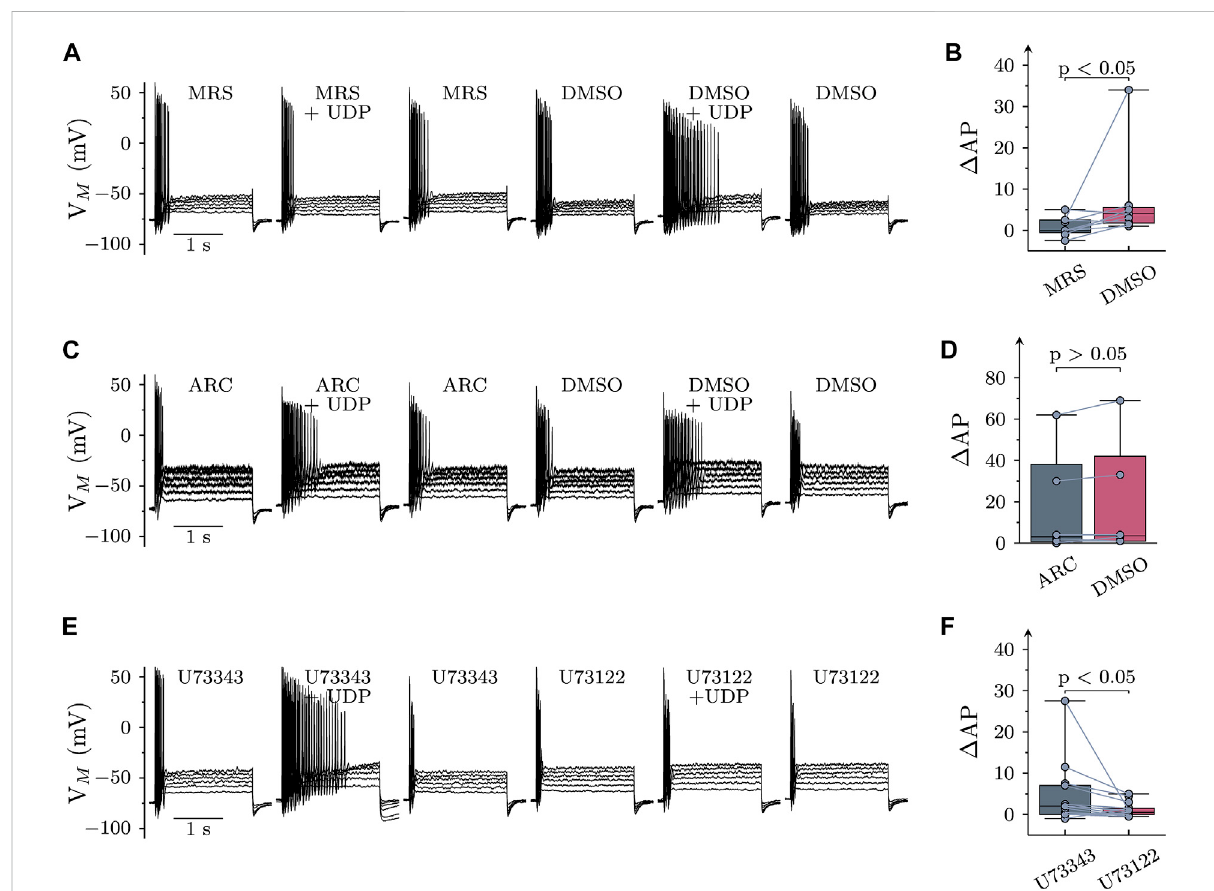
Roles of P2Y receptor subtypes and PLC in the effects of UDP on sympathetic neuron excitability. Membrane potential was measured in perforated-patch current clamp in single SCG neurons, and 6 depolarizing 2 s currents with amplitudes of 50, 100, 150, 200, 250, and 300 pA were injectedtotriggeractionpotentials. (A) Originalcurrentclamptraceswereobtained withMRS2578(MRS;1 µMin0.3%DMSO)beingpresentfor60 s before, during, and 300 s after application UDP (1 µM for 120 s); thereafter, MRS2578 was replaced by its solvent (DMSO), and UDP was applied again. (B) ChangesinAP fi ring ( Δ AP) inresponse toUDP ineither MRS2578(MRS) orsolvent (DMSO;n=9) as shownin (A) (C) Original current clamp traceswereobtainedwithAR-C118925XX(ARC;1 µMin0.3%DMSO)beingpresentfor60 sbefore,during,and300 safterapplication UDP(1 µMfor 120 s);thereafter, AR-C118925XX wasreplaced byitssolvent (DMSO),and UDP was applied again. (D) ChangesinAP fi ring ( Δ AP)inresponse toUDP in either AR-C118925XX (ARC) or solvent (DMSO; n = 9) as shown in (C) (E) Original current clamp traces were obtained with U73343 (3 µM in 0.1% DMSO) being present for 60 s before, during, and 300 s after application UDP (1 µM for 120 s); thereafter, U73343 was replaced by U73122 (3 µM in 0.1% DMSO), and UDP was applied again. (F) Changes in AP fi ring ( Δ AP) in response to UDP in either U73343 or U73122 as shown in E ( n = 15). Signi fi cances of differences were determined by Wilcoxon matched-pair signed rank